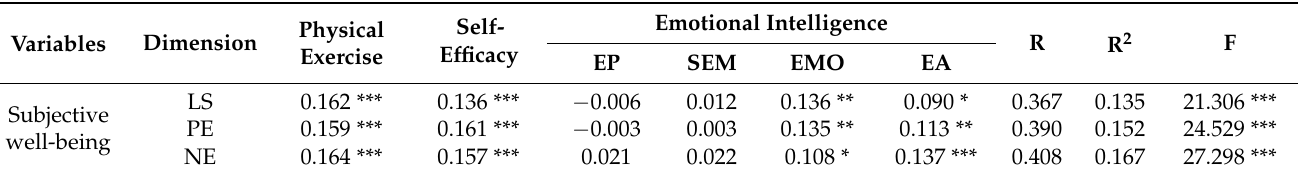
Table 6. Regression analysis among sub-dimensions of physical exercise, self-efficacy, emotional intelligence, and subjective